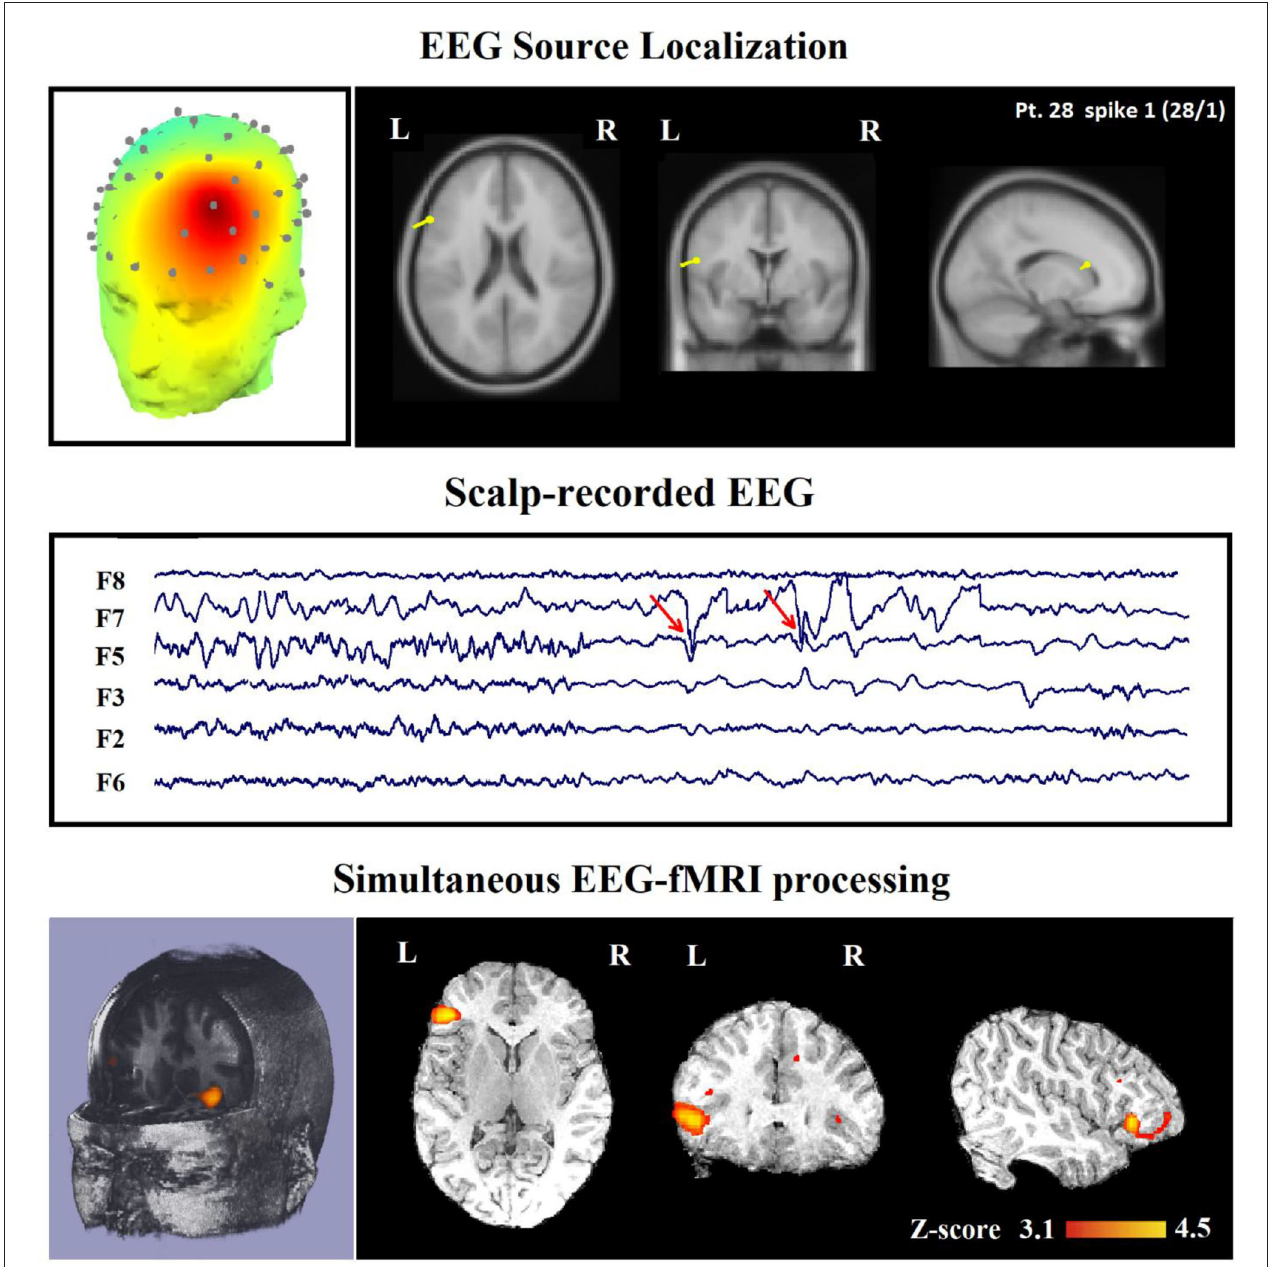
FIGURE 8 | (Patient 28—spike 1) marked events are F3, F5, and F7 spikes (referential montage) and the TCCC-related BOLD response demonstrates a neocortical activation in the inferior frontal gyrus. This response is considered concordant with the spike field but not contributory because it does not add any new information to the scalp EEG. Top, the component identified on scalp EEG located in the left frontotemporal lobe (left) and the dipole localization of the identified generator in deep brain structures (right). Middle, scalp recorded EEG. Bottom, Localization of the generator applying simultaneous analysis of EEG-fMRI. The active area is marked with a yellow-red